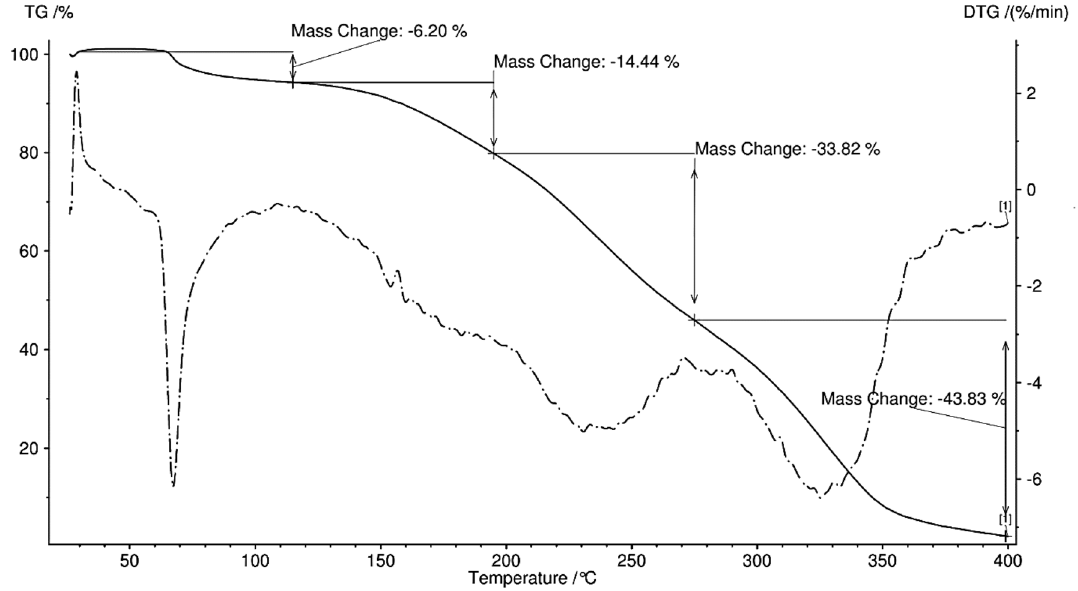
Figure 4. Thermogravimetric analysis of Fe 3 O 4